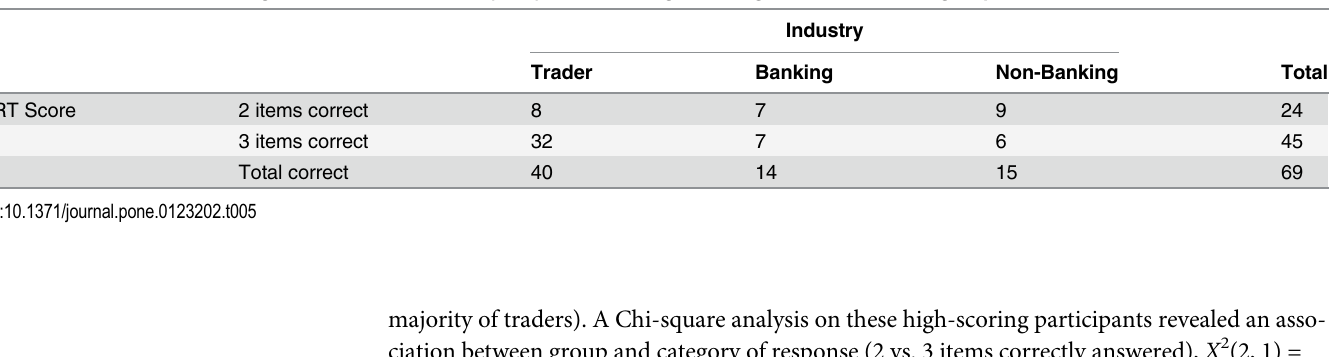
Table 5. Crosstabulation of cognitive reflection scores (CRT) counts for high-scoring males between all